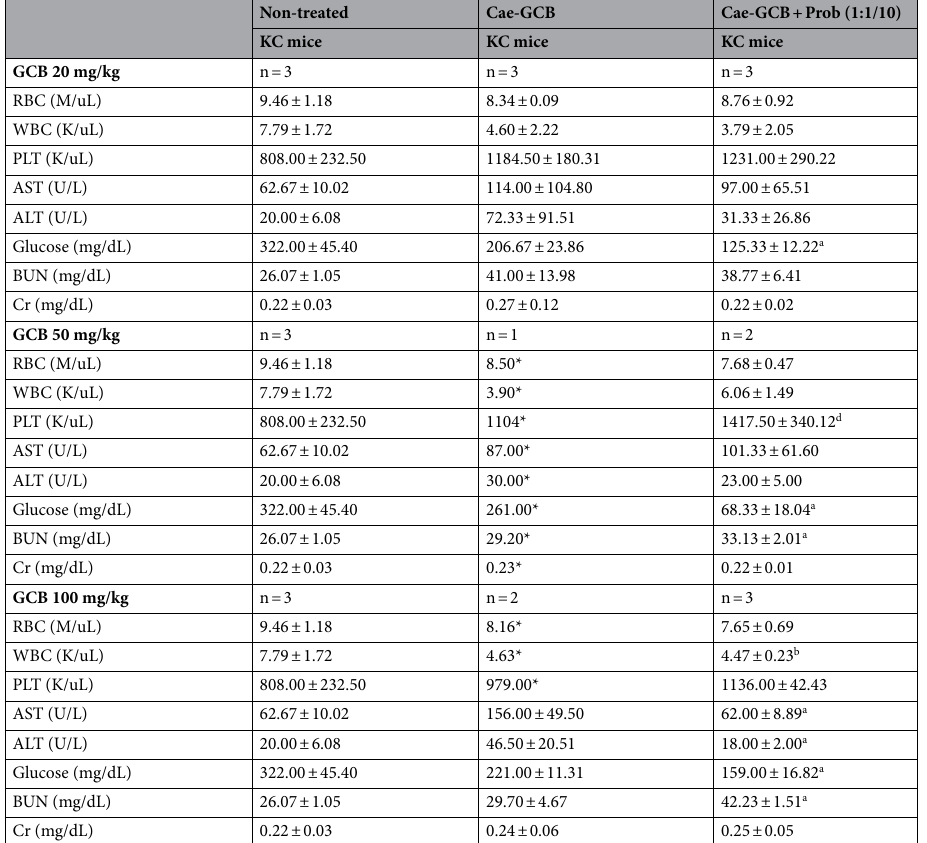
Table 1. Comparison of blood cell counts and biochemical values in KC transgenic mice after treatment with caerulein (Cae) and various doses of gemcitabine (GCB) with or without probiotics. ALT alanine aminotransferase, AST aspartate aminotransferase, BUN blood urea nitrogen, Cae-GCB caerulein(25 μg/ kg) + gemcitabine; Cae-GCB + Prob (1:1/10), caerulein (25 μg/kg) + gemcitabine + probiotics (GMNL133: GMNL89 = 1:1/10); Cr, creatinine; KC mice, LSL-Kras G12D/− -Pdx-1-Cre transgenic mice; PLT, platelet; Prob, probiotics; RBC, red blood cell; WBC, white blood cell. Data are presented as mean ± standard deviation (SD). a P ≦ 0.05 differences between Cae-GCB and Cae-GCB + Prob (1:1/10). b P ≦ 0.05 differences between Non- treated and Cae-GCB + Prob (1:1/10). * n = 1.